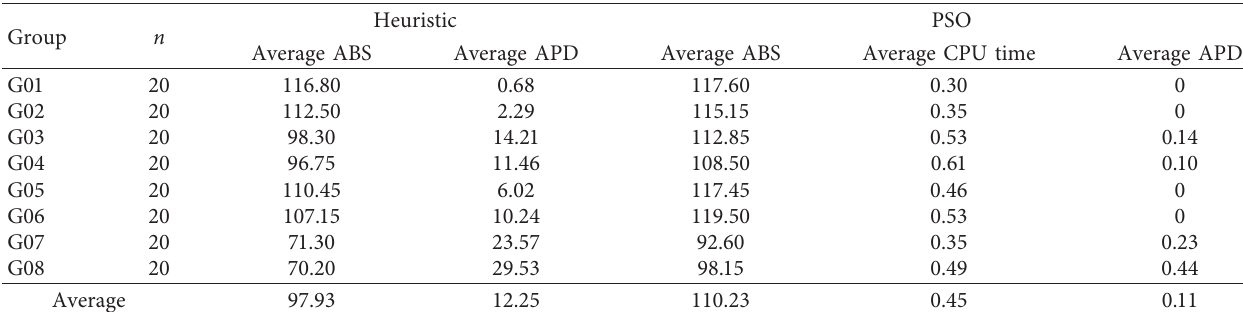
Table 5: Comparison of algorithms in TPP problem in small